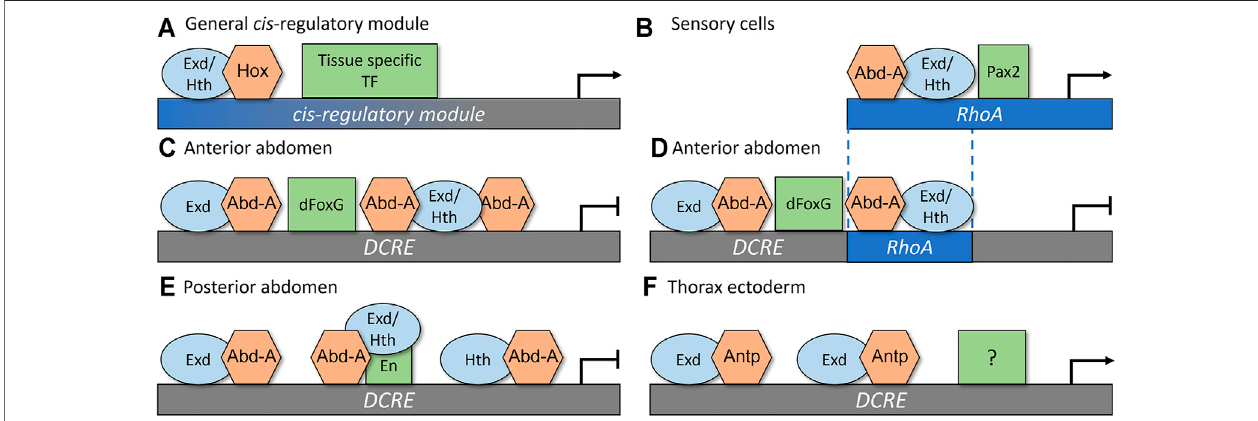
FIGURE 3 | Rhomboid-A ( RhoA ) and Distal-less conserved regulatory element ( DCRE ) are regulated through tissue speci fi c co-activators and co-repressors to mediate distinct transcriptional outputs. (A) A simplistic general model for how a Hox CRM yields cell-speci fi c outputs via the direct integration of a Hox factor with the common co-factors Exd and Hth, and a tissue speci fi c TF to mediate either activation or repression (B) In sensory cells, Abd-A, Exd, Hth, and Pax2 interact together to activate gene expression by forming complexes on the RhoA CRM. (C) In the anterior abdomen, Abd-A/Exd/Hth complexes bind together with dFoxG to repress the DCRE CRM. (D) Replacing two of the Hox binding sites from the DCRE with the Abd-A/Hth/Exd sites that mediate activation via the RhoA CRM did not alter the transcriptional response of the DCRE . These data show that the con fi guration of Hox binding sites does not dictate gene activation versus repression. Instead, it is the presence of nearby dFoxG sites [repression in (D) ] or Pax2 sites [activation in (B) ] that dictates transcriptional outcomes. (E) In the posterior abdomen, En interacts with Abd-AandExd/Hthtorepressthe DCRE CRM. (F) Inthethoraxectoderm,theAntpHoxfactorcooperativelybindswithExdtostimulategeneexpression.Thisactivation activitydoesnotrequirethedFoxGnortheEnsites.Inthismodel,weproposethatanunknowntissuespeci fi cTFmediatesactivationof DCRE CRMtoresultinectoderm speci fi c gene activation.